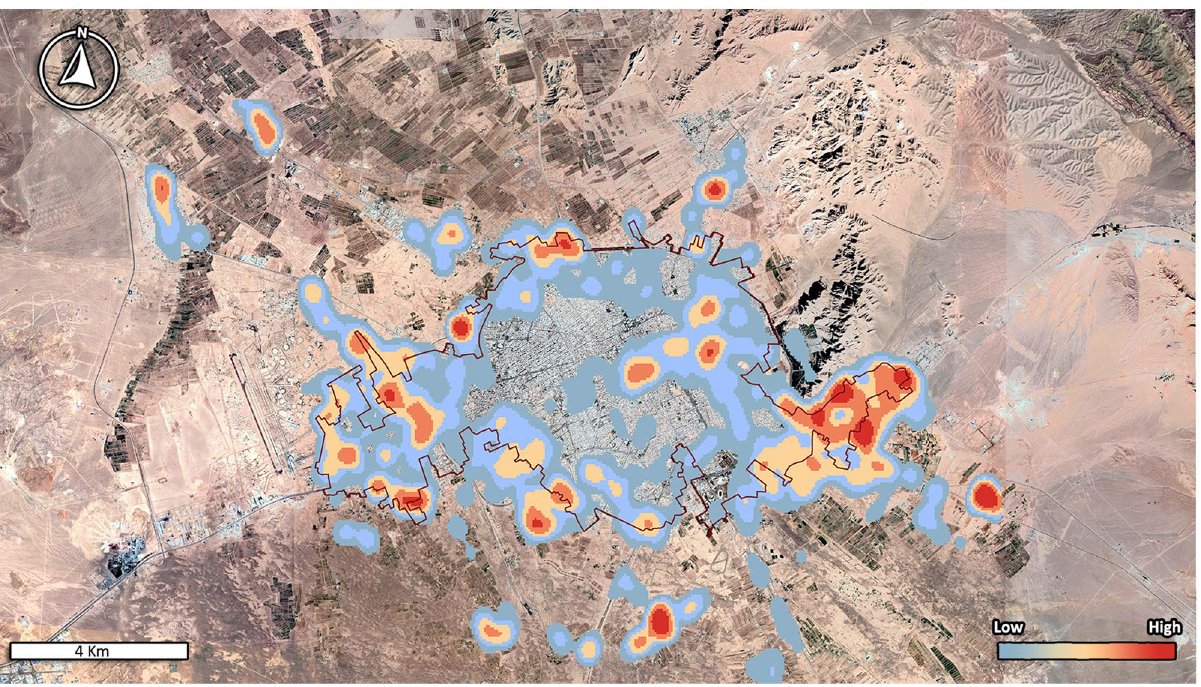
Figure 2. Estimated free-roaming dog population density in Kerman city and suburbs, Iran. This map was generated by ArcGIS 10.2 software with the Kernel technique (https:// www. esri. com/ en- us/ arcgis/ produ cts/ arcgis- pro/ overv iew) using Google Earth Pro 7.3.4.8248